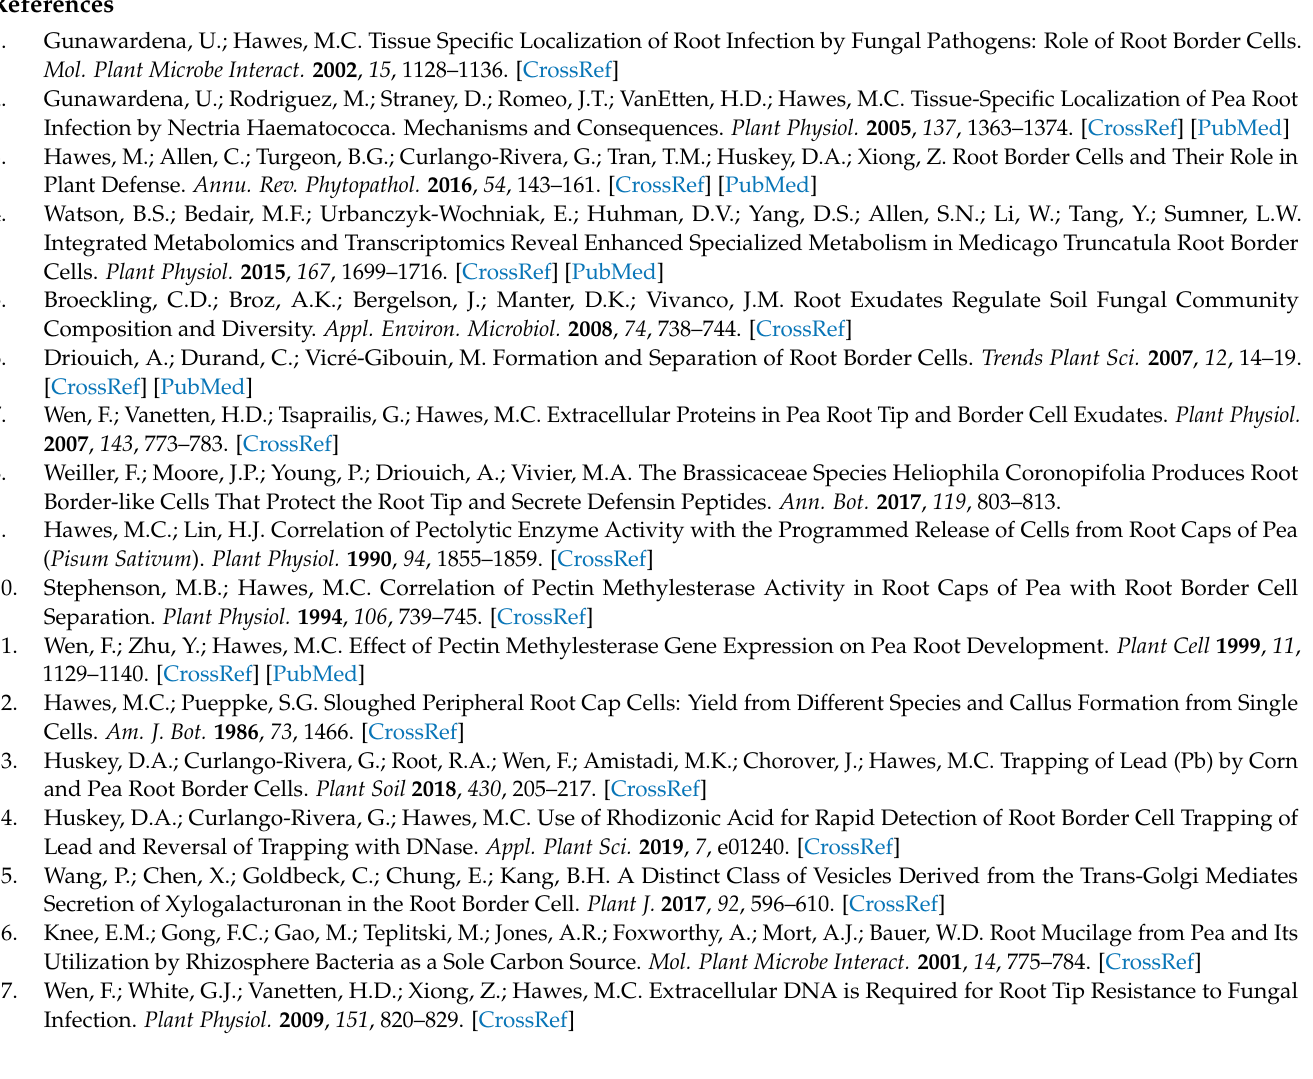
data. Figure S1. Visualization of GC-MS metabolites in the Medicago truncatula Metabolite Atlas. Figure S2. Biosynthetic pathways of phenylalanine and tryptophan (KEGG). Figure S3. Biosynthetic pathway of 7,4 (cid:48) -dihydroxyflavone (DHF)